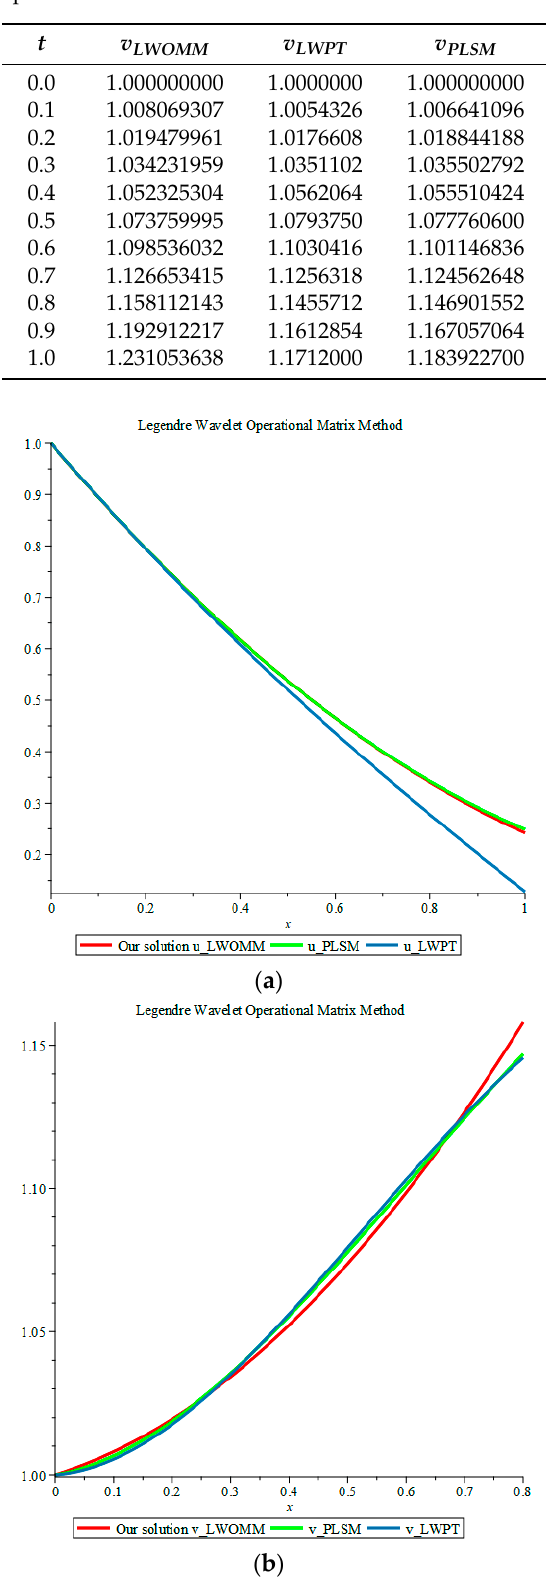
Figure 4. Comparison of our solutions to the approximate solution LWPT and the approximate solution PLSM when α = 0.98 for Example 5: ( a ) Our solution u ( t ); and ( b ) Our solution v ( t